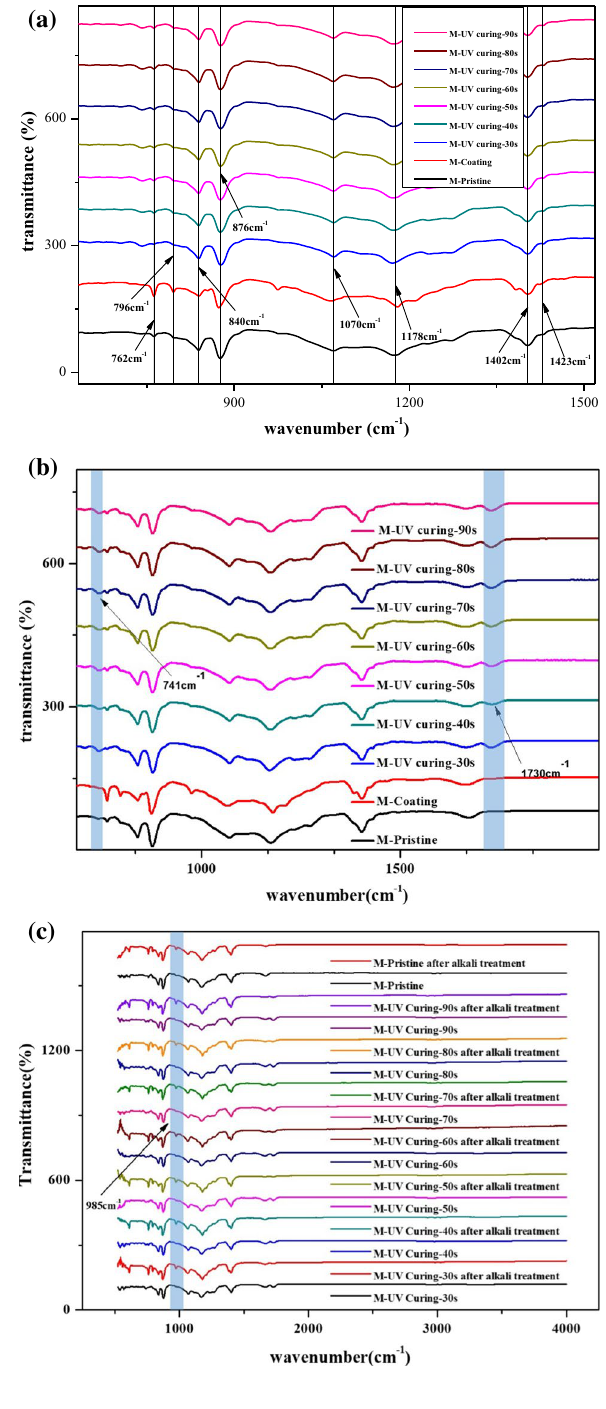
Fig. 6 a Changes of crystal form in ATR-FTIR spectrum after UV- curing resin modification. b Changes of functional groups in ATR- FTIR spectrum after UV-curing resin modification. c Changes of functional groups of pristine PVDF membrane and UV-curable resin- modified PVDF membrane after alkali